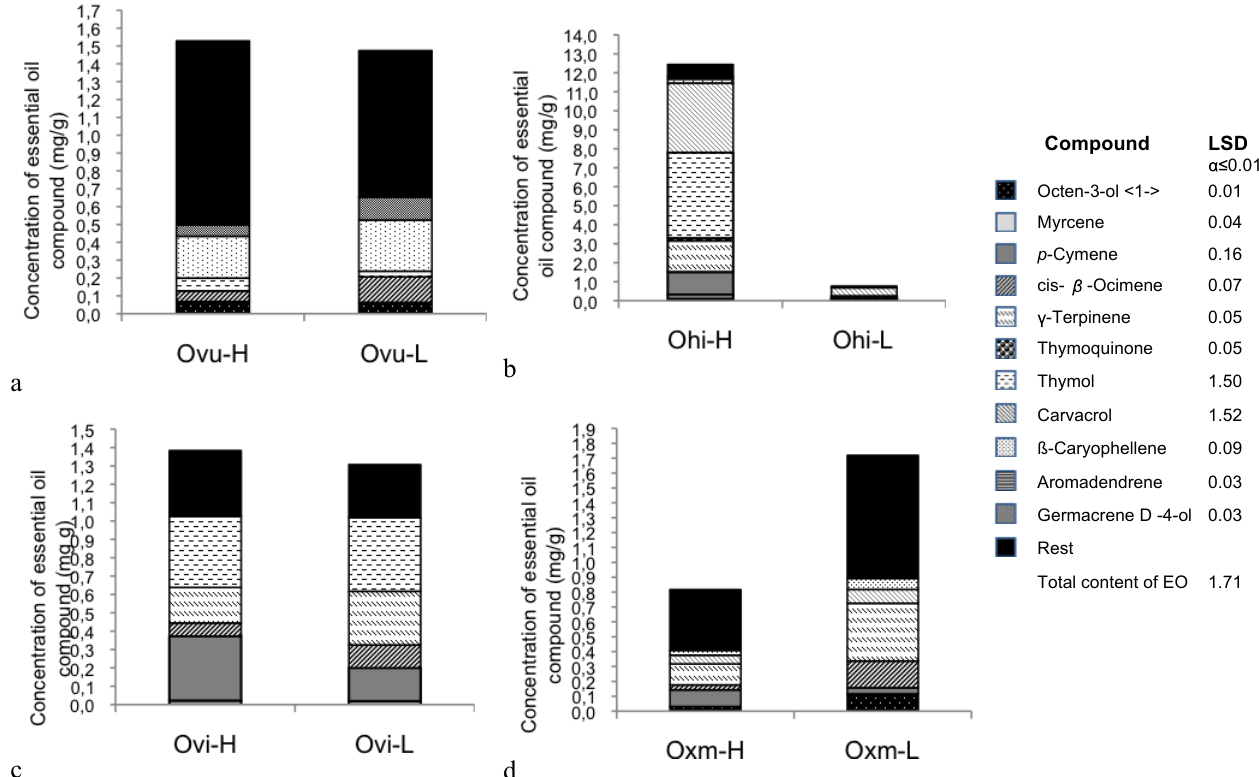
Fig. 2: Composition of essential oil in herb (H) and third leaf (L) samples of Origanum vulgare accessions Ovu: Origanum vulgare ssp. vulgare Ohi: Origanum vulgare ssp. hirtum Ovi: Origanum vulgare ssp. viride Oxm: Origanum vulgare ssp. viride ×